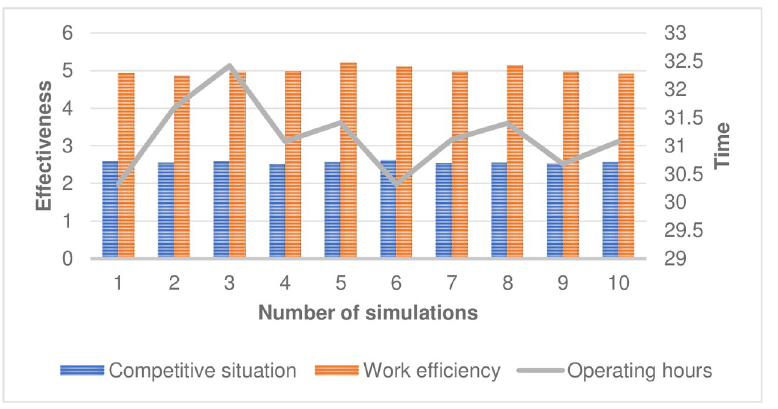
Fig 1. Curve of comparison of simulation